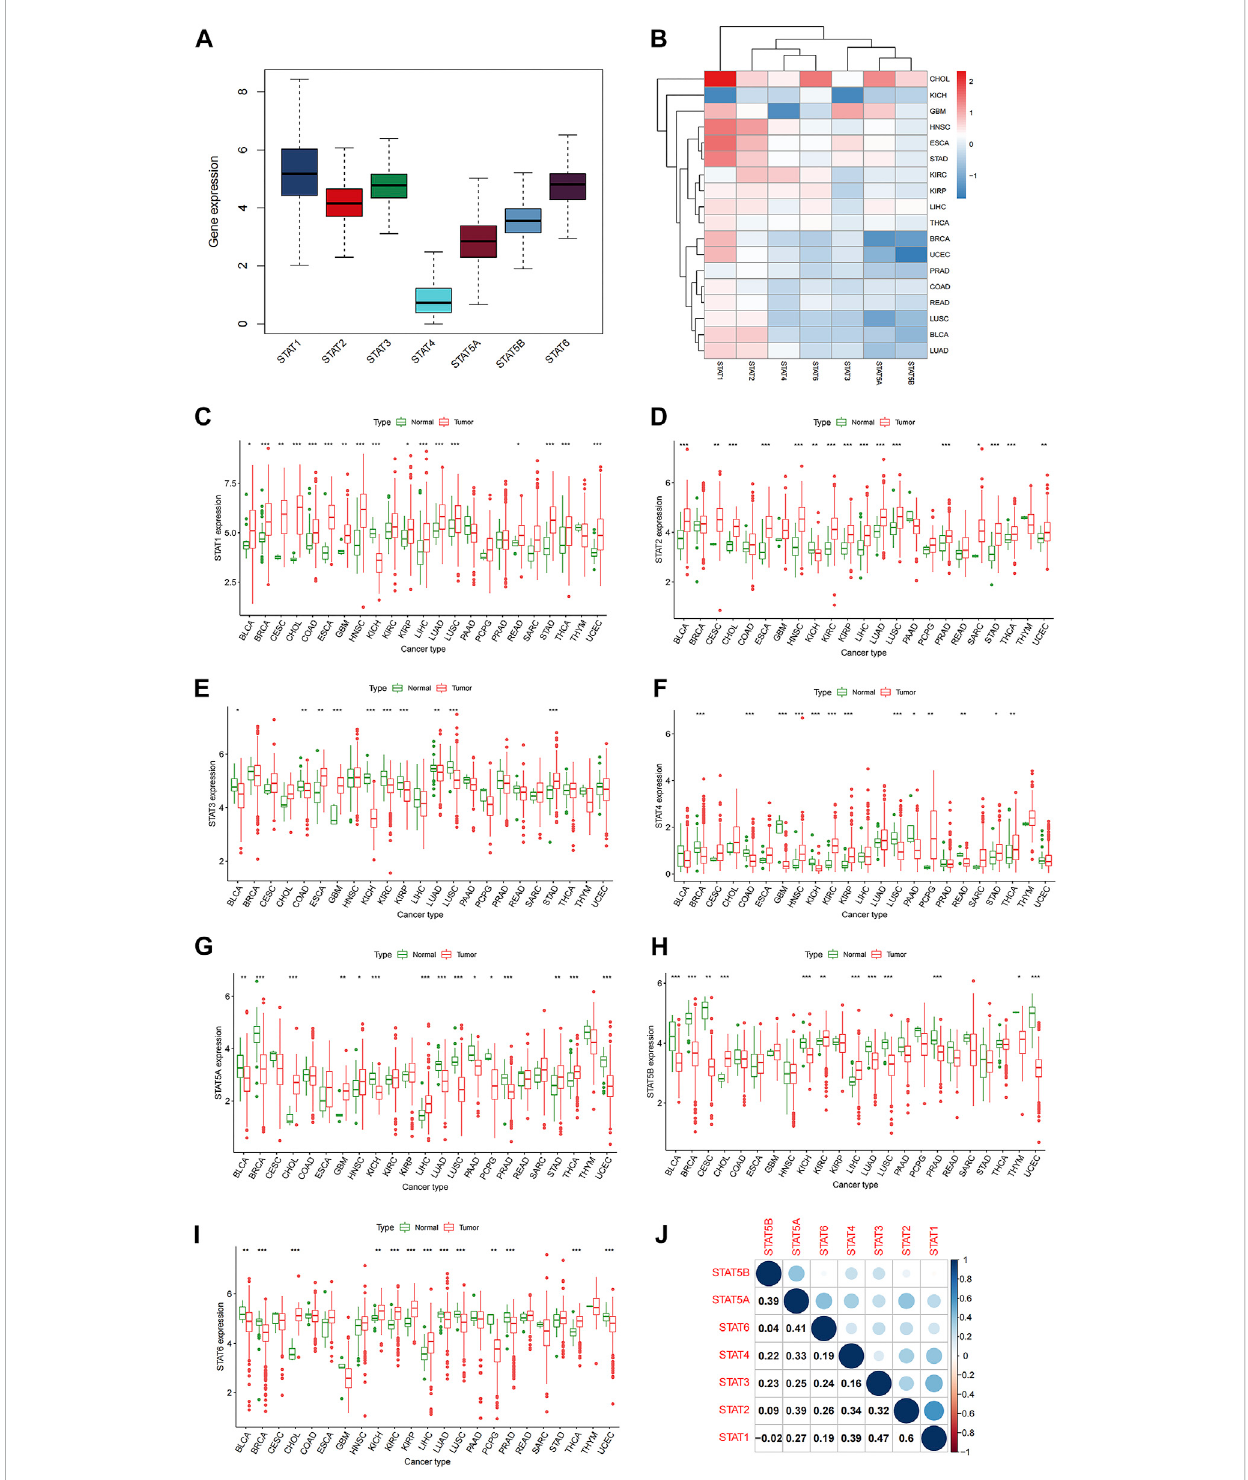
FIGURE 2 DifferentialexpressionanalysisofSTATsinpan-cancer. (A) BoxplotdemonstratingtheaveragegeneexpressionlevelsofSTATsinalltumortypes. (B) Heatmap revealing the expression levels of STATs measured by log2FC in different tumor types. (C) Box plots showing the average expression levels of STAT1 between normal and tumor tissues of 23 tumor types, in which BLCA ( p < 0.05), BRCA ( p < 0.001), CESC ( p < 0.01), CHOL ( p < 0.001), COAD ( p < 0.001), ESCA ( p < 0.001), GBM ( p < 0.01), HNSC ( p < 0.001), KICH ( p < 0.001), KIRP ( p < 0.05), LICH ( p < 0.001), LUAD ( p < 0.001), LUSC ( p < 0.001), READ ( p < 0.05),STAD ( p < 0.001), THCA( p < 0.001), andUCEC( p < 0.001)exhibited statistical signi fi cance. (D) Boxplots showingtheaverageexpression levels of STAT2 between normal and tumor tissues of 23 tumor types, in which BLCA ( p < 0.001), CESC ( p < 0.01), CHOL ( p < 0.001), ESCA ( p < 0.001), HNSC( p < 0.001),KICH( p < 0.01),KIRC( p < 0.001),KIRP( p < 0.05),LICH( p < 0.001),LUAD( p < 0.001),LUSC( p < 0.001),PRAD( p < 0.001),SARC( p < 0.05), STAD ( p < 0.001), THCA ( p < 0.001), and UCEC ( p < 0.01) presented statistical signi fi cance. (E) Box plots showing the average expression levels of